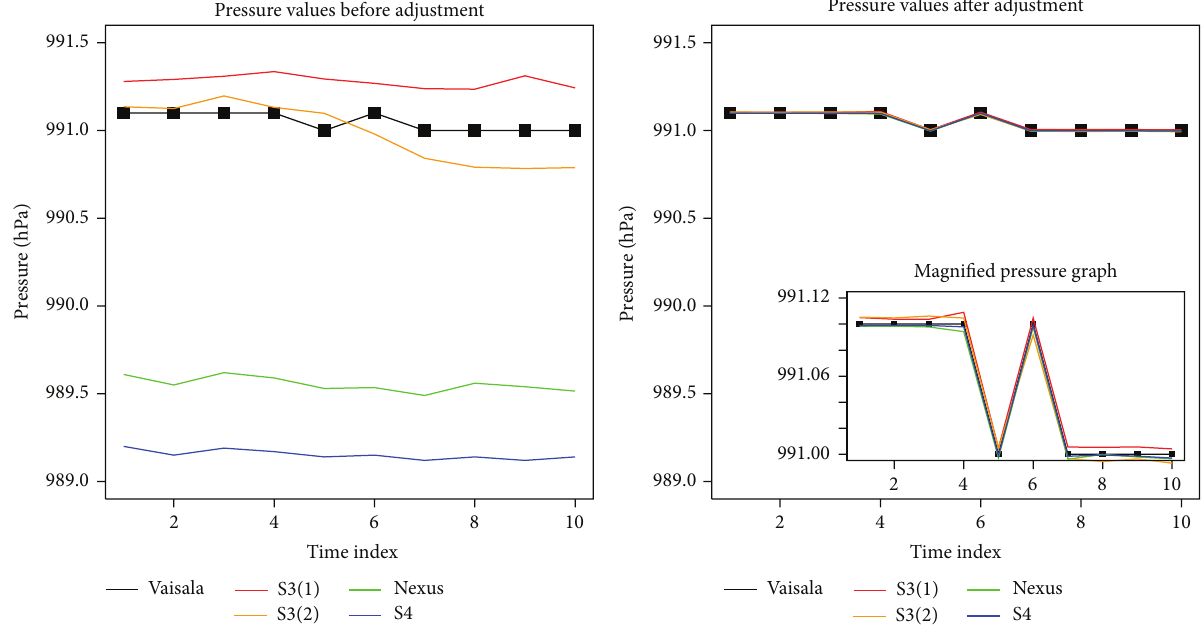
Figure 4: Comparison of pressure per minute before and after